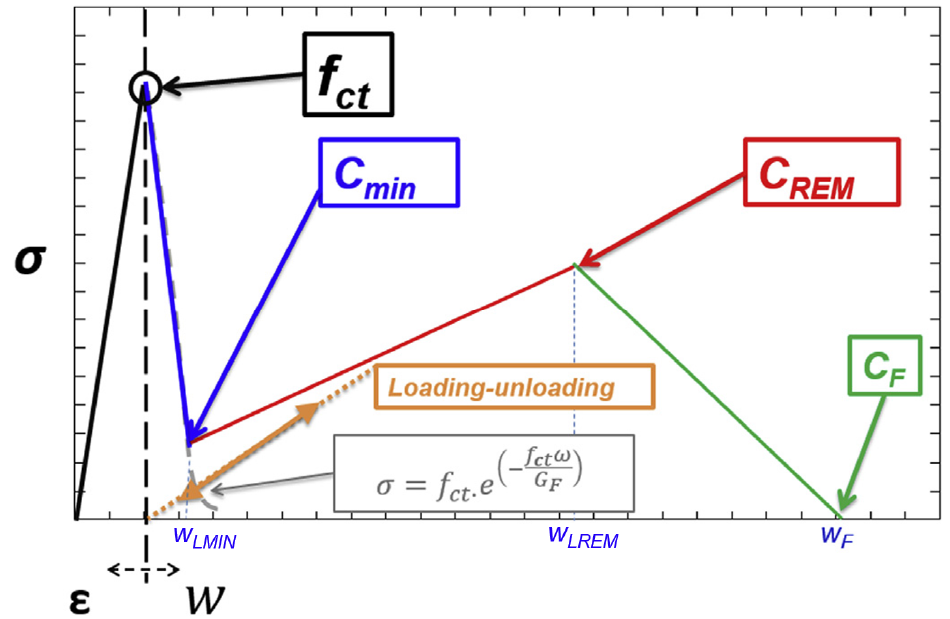
Figure 9. Sketch of the shape and position of the turning points of the constitutive relations for polyolefin fiber-reinforced concrete (PFRC).